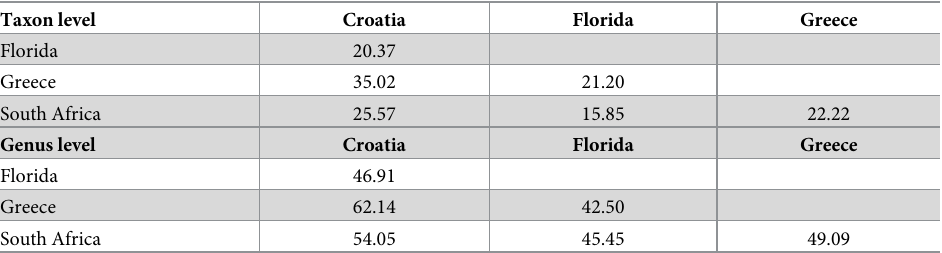
The index was calculated at both species and genus level, expressed as